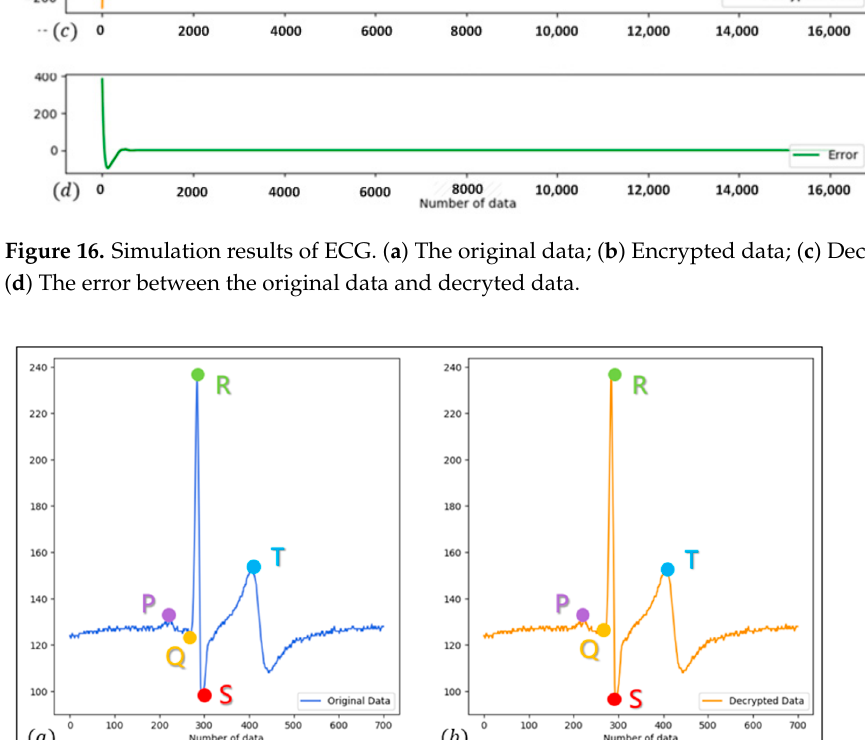
Figure 17. Simulation results of ECG. ( a ) The original data; ( b ) Decrypted data.